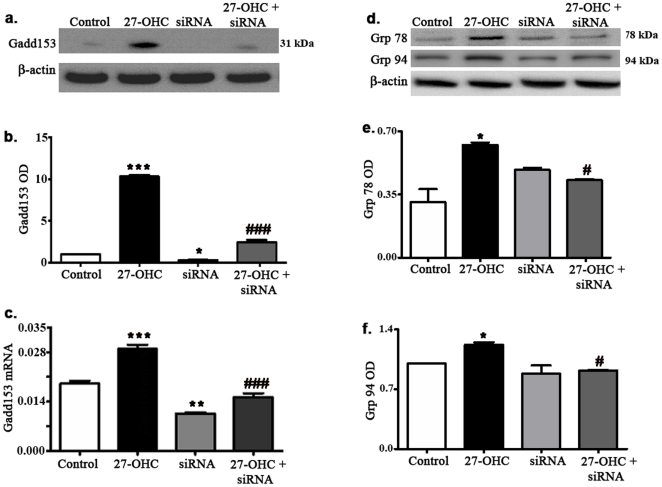
siRNA to gadd153 reduces 27-OHC-induced alteration in ER protein levels in organotypic slices from rabbit hippocampus.27-OHC significantly increased protein levels (a,b) as well as mRNA (c) of gadd153 and treatment with siRNA to gadd153 markedly reduced the 27-OHC-induced increase in expression levels of gadd153. Treatment with siRNA also reduced the increase in levels of the ER chaperones grp 78 and and grp 94 induced by 27-OHC (d–f). *p<0.05, **p<0.01 and ***p<0.001 versus controls; #p<0.05 and ###p<0.001 versus 27-OHC.